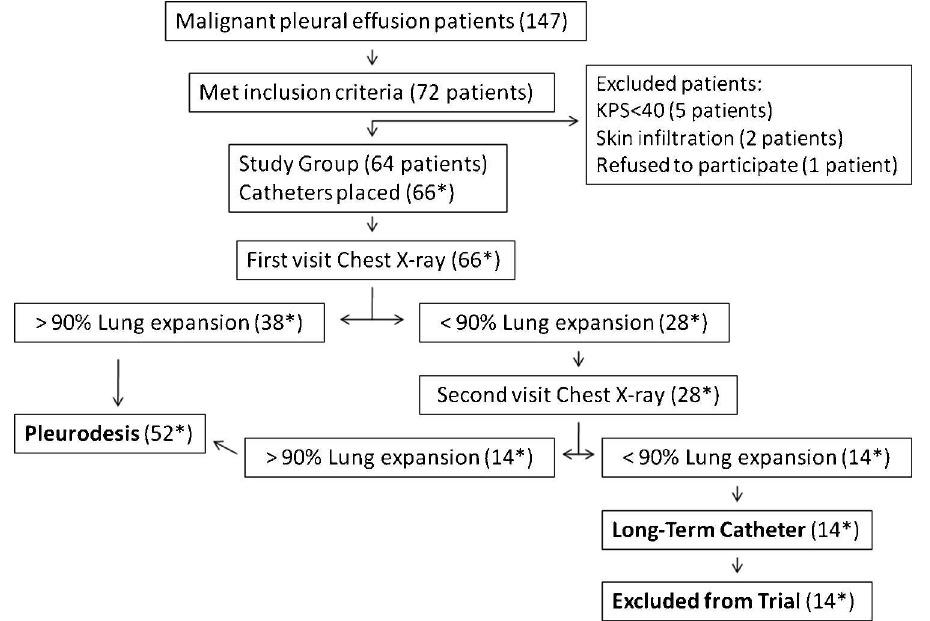
Figure 2 - Flow of the patients. * Those numbers depict the number of catheters placed and therefore the number of drained hemithoraces (two patients had bilateral procedures). Long-term catheters patients – patients who underwent chest tube placement but were excluded from the